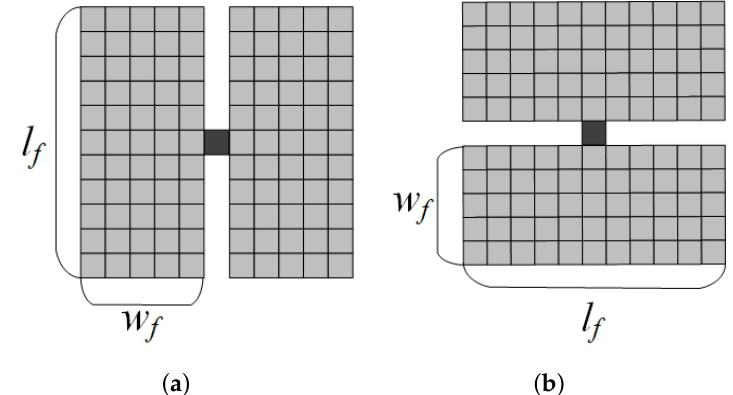
Figure 2. Edge detection filter configuration, l f : length of the filter, w f : width of the filter, l f = 2 × w f + 1. ( a ) Filter setting for the horizontal gradient calculation. ( b ) Filter setting for the vertical gradient calculation.